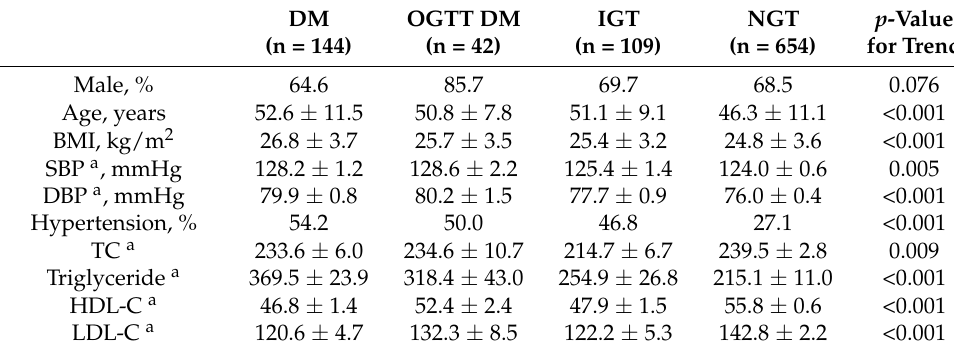
Table 2. Cardiovascular factors in clinical subjects receiving